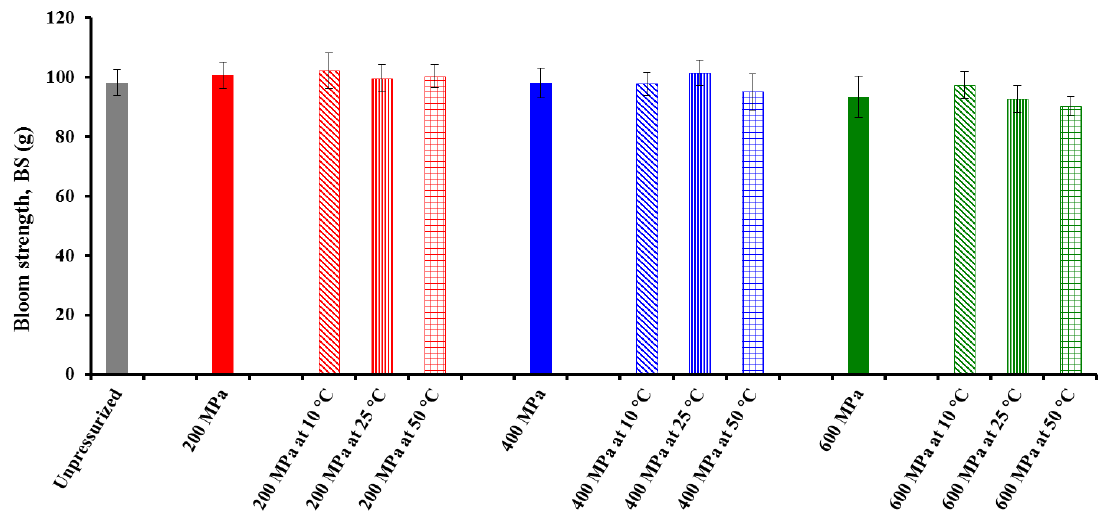
Figure 4. Effect of pressure and treatment temperature on bloom strength ( BS ) of chickpea gel heat-induced from pressurized powder at 25 °C. Mean values of 10 measurements.